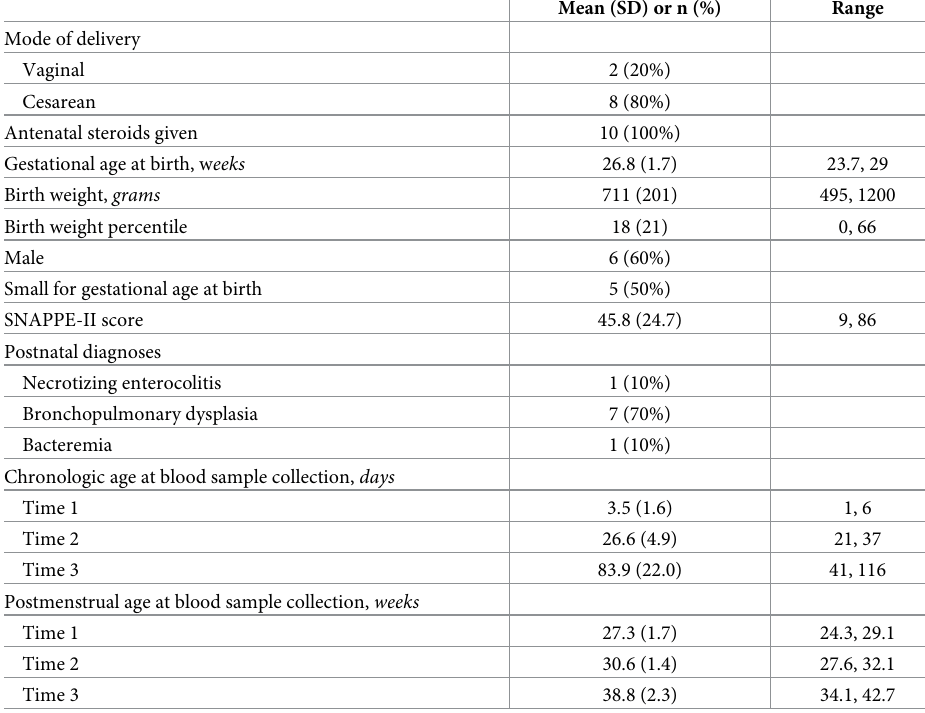
Table 1. Participant characteristics (n = 10).